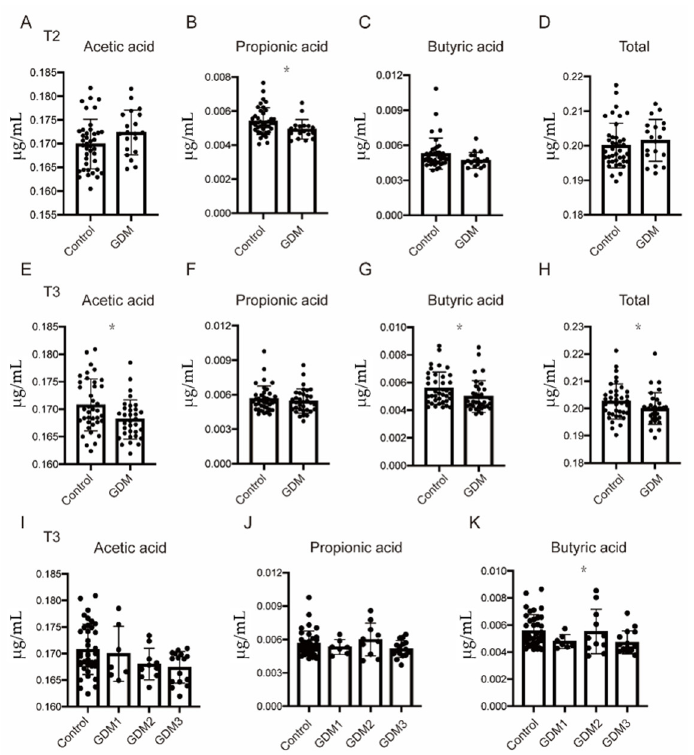
Figure 1. The levels of three dominant SCFAs and total SCFA were decreased among GDM pregnan- cies. ( A – D ) Circulating levels of acetic, propionic, butyric, and total acids in T2. ( E – H ) Circulating levels of acetic, propionic, butyric, and total acids in T3. ( I – K ) Circulating levels of acetic, propionic, and butyric acid among the control and GDM subtypes in T3. Data are presented as the mean ± SD. * p < 0.05, significant difference vs. control group.